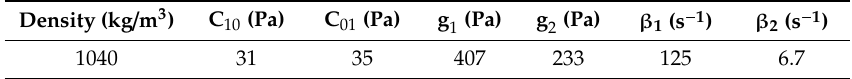
Table 2. Mooney–Rivlin hyper-viscoelastic constants of the brain used in FE modeling [1].